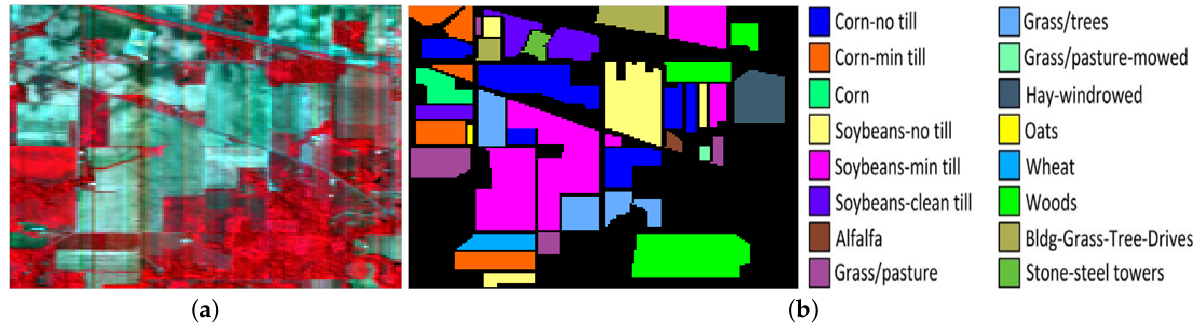
Figure 12. Thematic maps for the Indian Pines data set with 16 classes. ( a ) false-color composite; ( b ) ground truth data with 16 classes in different